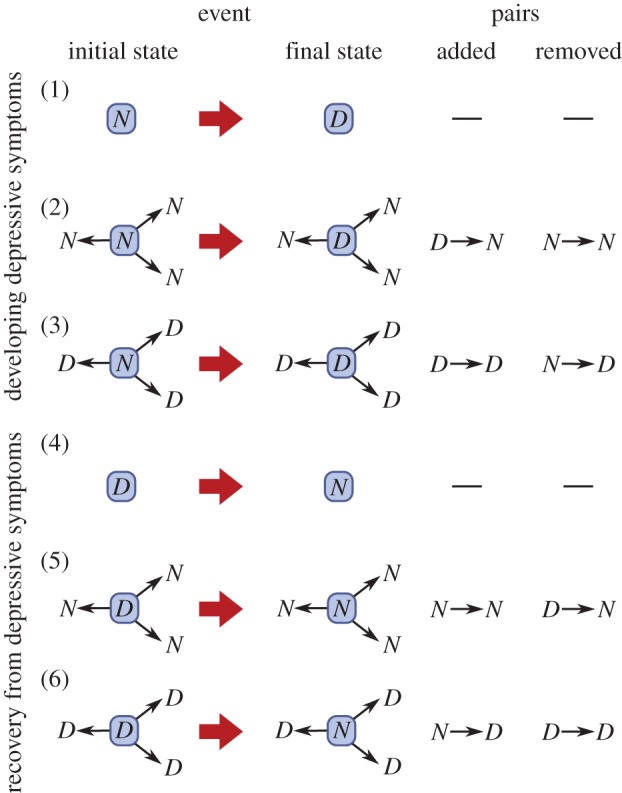
Pictorial representation of the possible events in our model: developing or recovering from depressive symptoms; in the absence of friends, with friends with healthy mood, or with depressed friends. The changes in pairs produced are also shown.